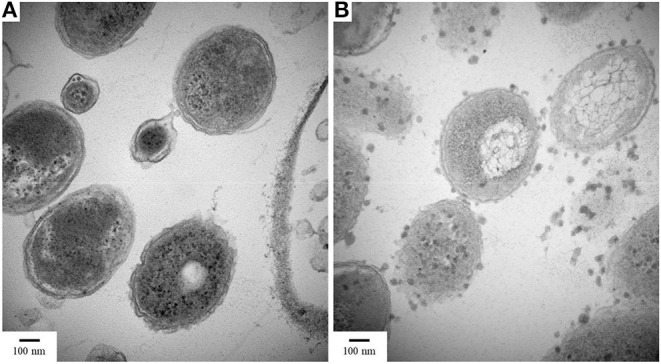
TEM images of cultures growing with oleate and (A) elemental sulfur or (B) thiosulfate. Samples were taken on day 50 of the reactors' operation. Magnification 80,000x.